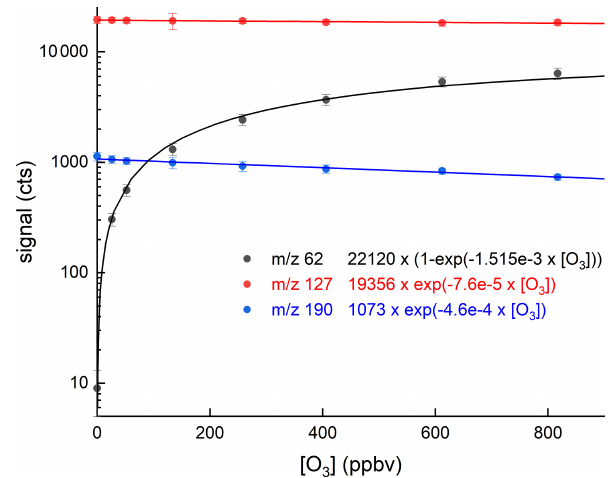
Figure 8. Dependence of the signals at m/z 62 and m/z 190 on the O 3 mixing ratio with HNO 3 fixed at 12.5ppbv. The lines through the data are described by the expressions listed in the